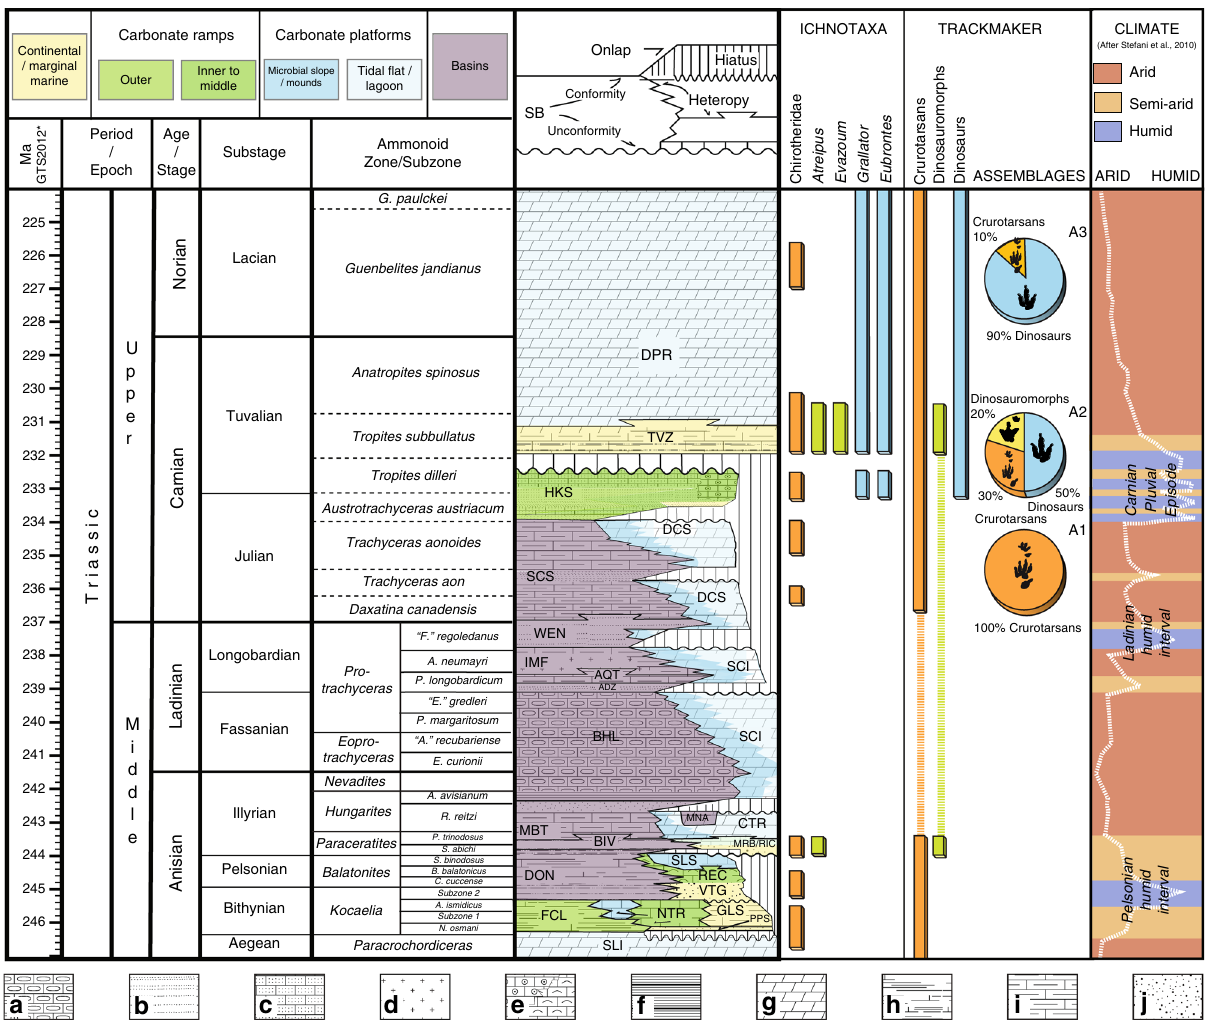
Fig. 1 Stratigraphy in the Italian Dolomites, and dating the dinosaur diversi fi cation event. Footprint occurrences within the chrono-stratigraphic framework of the middle and upper Triassic of the Dolomites (Southern Alps, NE Italy), and the derived abundances of dinosaurian, non-dinosaurian dinosauromorph and crurotarsan trackmakers within the associations A1, A2, and A3 described in the text. Note the correlation between the change in composition of the associations and the climate shifts (climate trend and zones after ref. 11 ). Lithostratigraphic abbreviations: ADZ: Zoppè Sandstone; AQT: Acquatona Formation; BHL: Livinallongo/Buchenstein Formation; BIV: Bivera Formation; CTR: Contrin Formation; DCS: Cassian Dolomite; DON: Dont Formation; DPR: Dolomia Principale; FCL: Coll ’ Alto dark Limestones; GLS: Gracilis Formation; HKS: Heiligkreuz Formation; IMF: Fernazza Formation and volcanites; MBT: Ambata Formation; MNA: Moena Formation; MRB/RIC: Richthofen Conglomerate and Morbiac dark Limestone; NTR: Monte Rite Formation; PPS: Piz da Peres Conglomerate; REC: Recoaro Limestone; SCI: Sciliar Formation; SCS: San Cassiano Formation; SLI: Lower Serla Dolomite; SLS Upper Serla Formation; TVZ: Travenanzes Formation; VTG: Voltago Conglomerate; WEN: Wengen Formation. Lithologies: a cherty limestone; b sandstone; c sandy limestone; d volcanics; e oolitic-bioclastic limestone; f black platy limestone or dolostone, black shale; g dolostone; h marlstone, claystone and shale; i marly limestone; j conglomerate. Ages from GTS timescale, modi fi ed after refs 12, 91, 92 . The silhouette images were created by the authors for use in this region between Switzerland and Italy 25 , and Poland-Slovakia (Tomanová Formation 35 ). Large sauropodomorph tracks ( Eosaur-